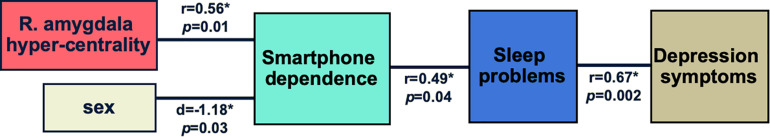
Proposed model of how smartphone dependence is linked to aberrations in brain networks, sex, sleep problems, and depressive symptoms. The results obtained in this study are shown: r stands for Pearson’s correlation coefficient, d - for Cohen’s d. *indicates statistical significance at 0.05 level. It needs to be emphasized that due to the limited sample size we did not test this model as a whole but rather explored individual bivariate correlations.